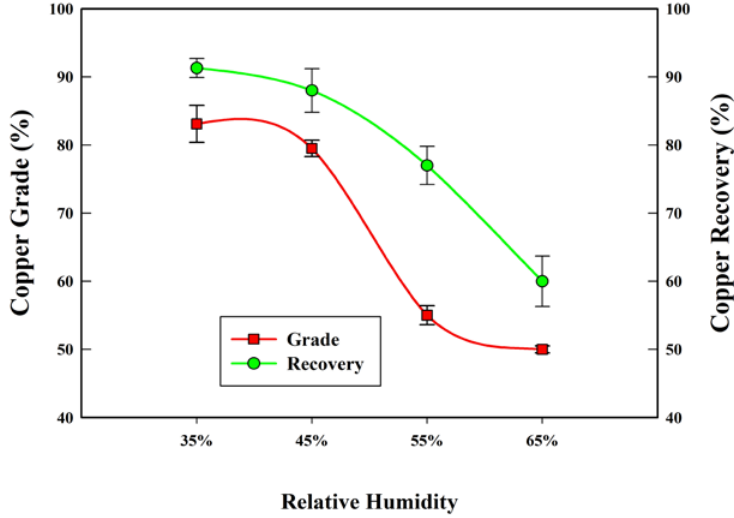
(splitter position: 8 cm, relative humidity: 35%, distance between electrodes: 60 cm).